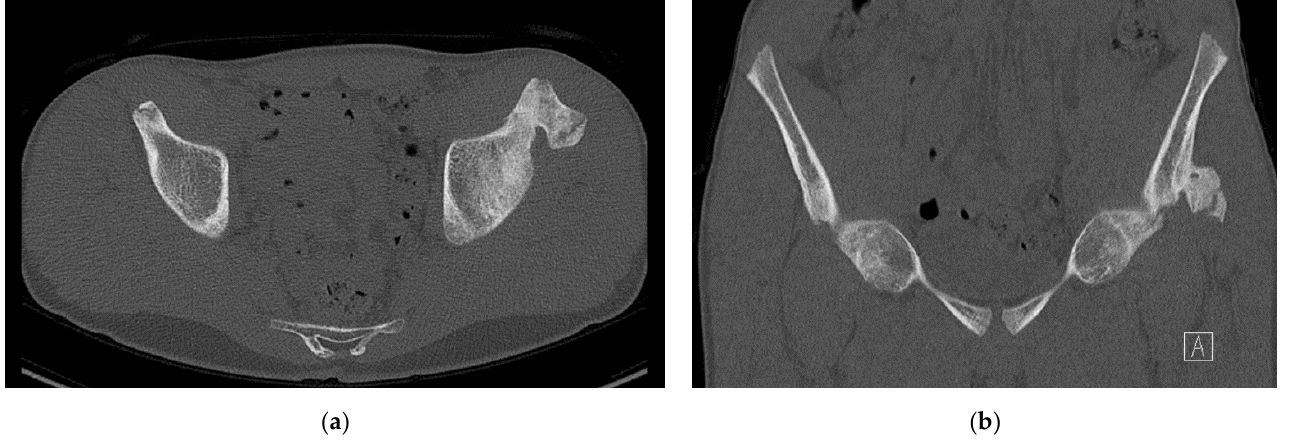
Figure 2. Computed tomography scan with an axial ( a ) and a coronal ( b ) view of the osseous calci- fication on the left anterior inferior iliac spine, showing a heterotopic ossification of the origin of the rectus femoris tendon.